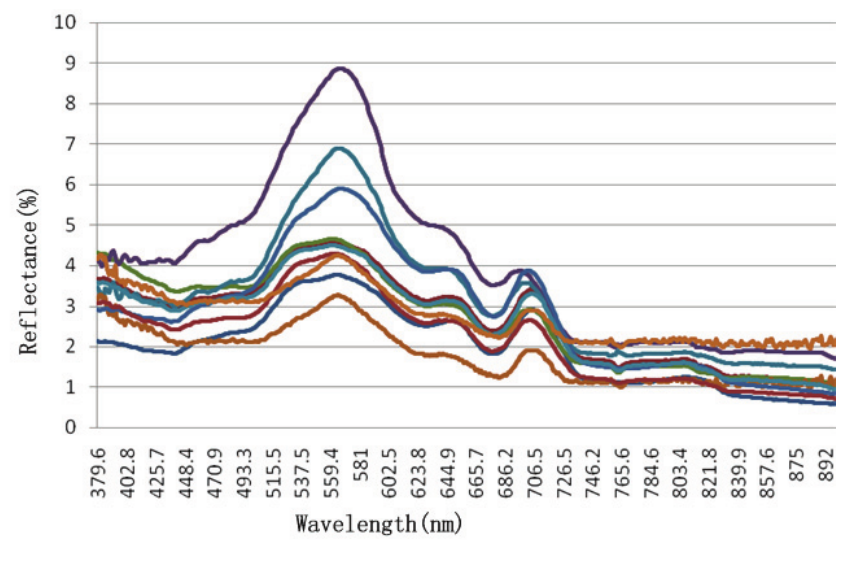
Figure 3. Reflectance spectra at 10 sampling sites in Tangxun